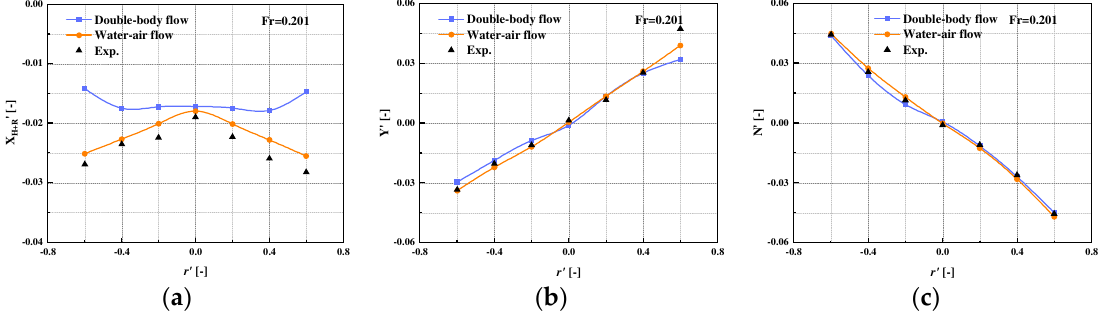
' Y (cid:48) . ( b ): Y (cid:48) . ( c ): N (cid:48) X . ( c ): H + R + . ( b ): H R